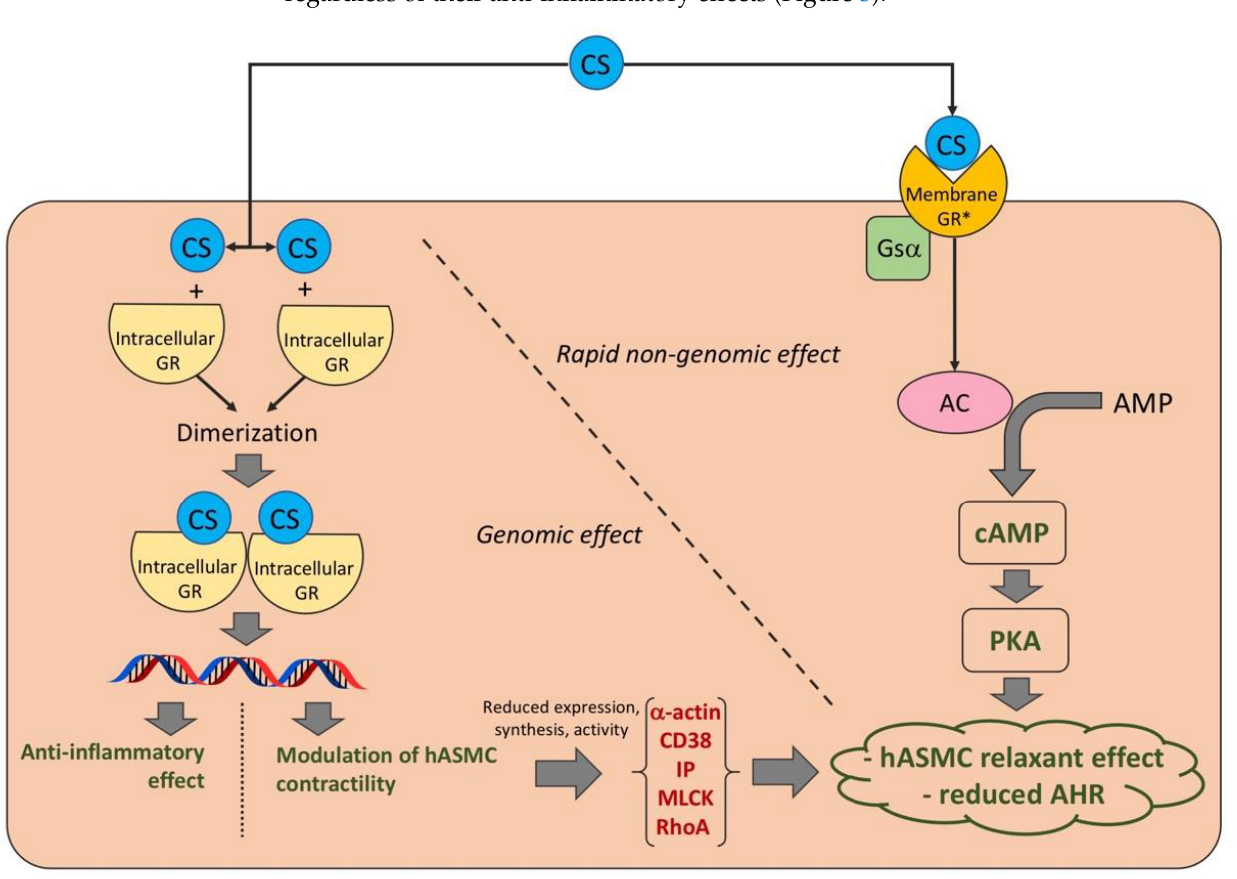
Figure 3. Genomic and rapid non-genomic effect of CS on human ASM contractility and AHR. * Putative non-classic membrane receptors characterized by pharmacological properties that are different from those of classic intracellular GR. AC: adenylyl cyclase; AHR: airway hyperresponsiveness; AMP: adenosine monophosphate; cAMP: cyclic adenosine monophosphate; CS: corticosteroids; GR: glucocorticoid receptors; hASMC: human airway smooth muscle cells; IP: inositol phosphate; MLCK: myosin light chain kinase; PKA: protein kinase A; and RhoA: ras homolog family member A. More specifically, CS are effective in vitro in reducing either the expression, synthesis or activity of α -actin, CD38, IP, MLCK, and RhoA in response to several stimuli